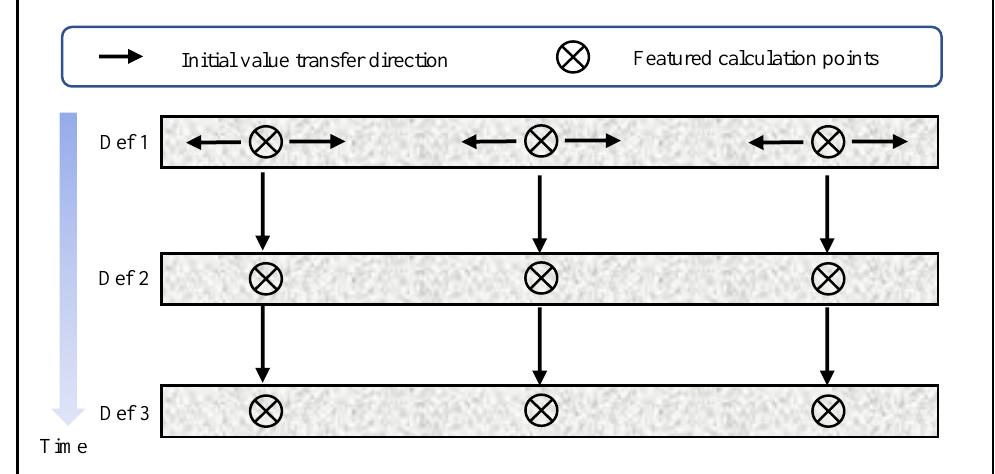
Figure 5. Illustration of initial displacement value transfer direction.